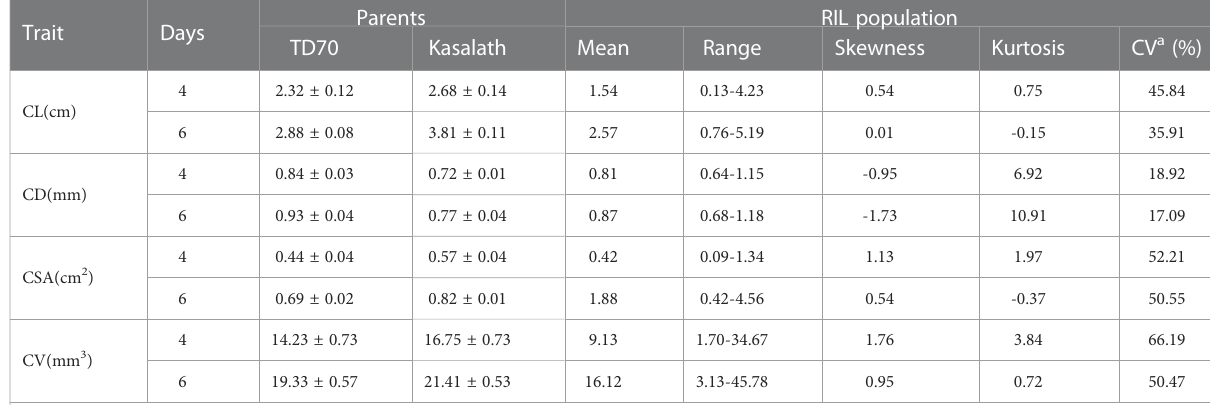
TABLE 1 Phenotypes of TD70, Kasalath and RIL population of offspring at two germination stages under anaerobic conditions.